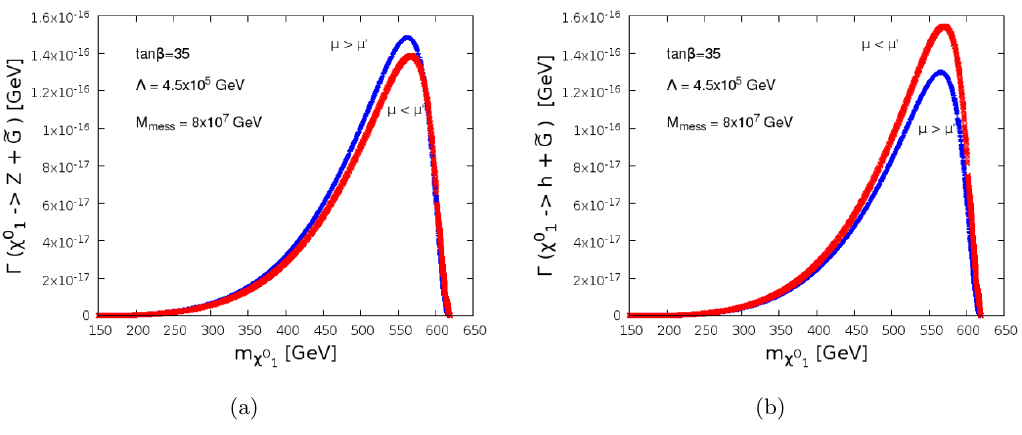
Figure 8 . Plot of decay width vs. NLSP mass for